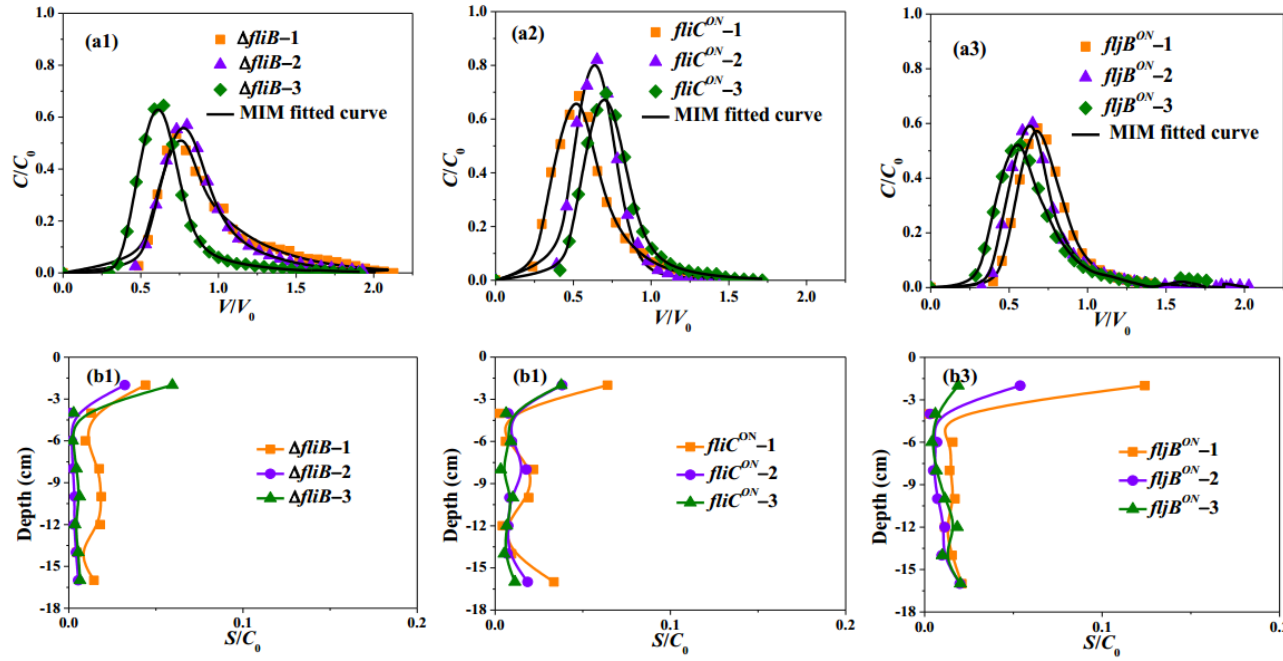
Figure 2. ( a1 – a3 ) Observed (symbols) and fitted (lines) breakthrough curves; ( b1 – b3 ) Observed retention profiles of S. Typhimurium motile Δ fliB , motile fliC ON , and motile fljB ON mutants. retention profiles of S. Typhimurium motile ∆ fliB , motile fliC ON , and motile fljB ON